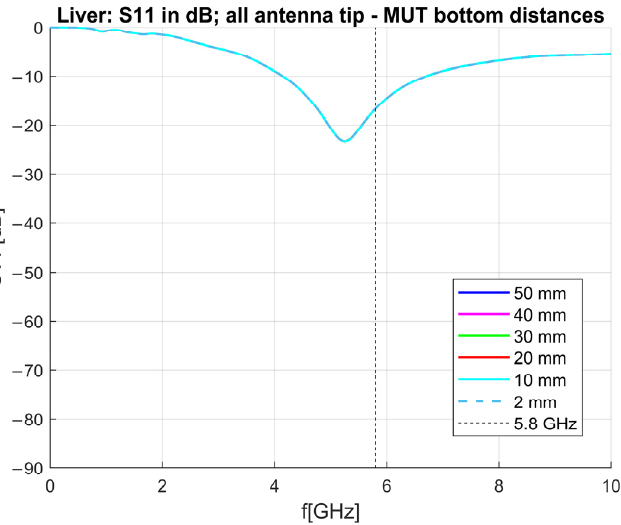
Figure 17. Reflection coefficient in dB simulated in livers of different antenna tip—MUT bottom Reflection coefficient in dB simulated in livers of different antenna tip—MUT distances. bottom